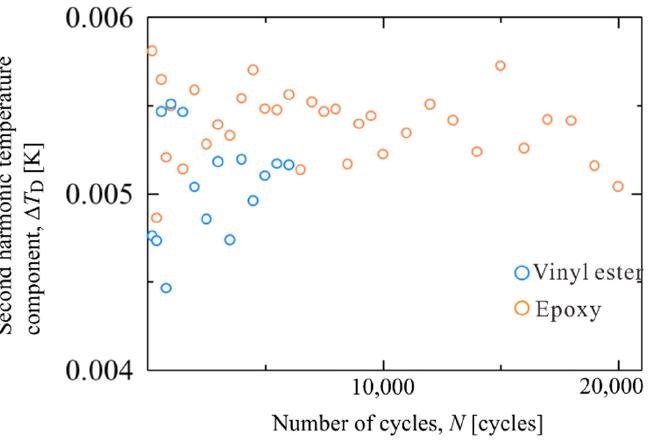
Figure 9. Second harmonic temperature component for epoxy and vinyl ester specimen.